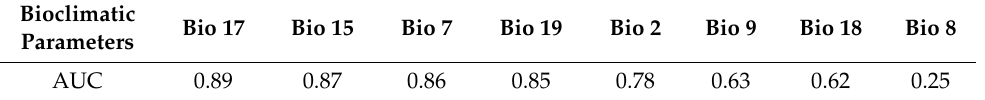
Table 1. Parameters of AUC for Z. tenebrioides for each factor, obtained using jackknife method.